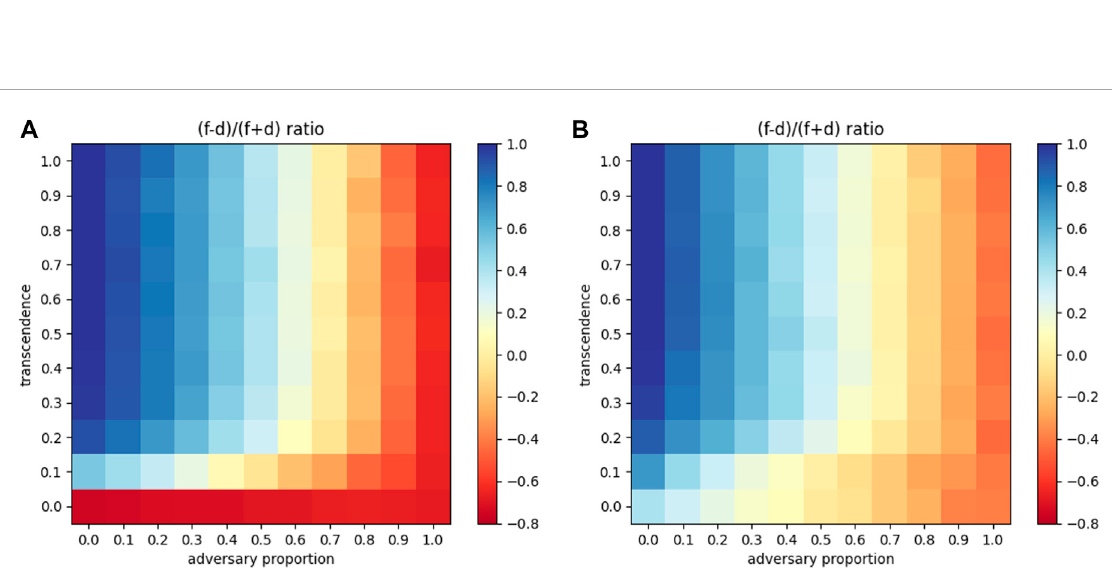
Frontiers in Robotics and